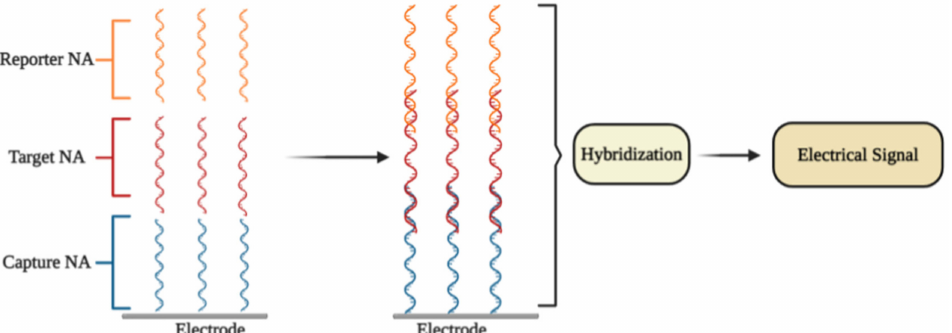
Figure 2. The general principle of electrochemical affinity biosensors for the detection of specific nucleic acid